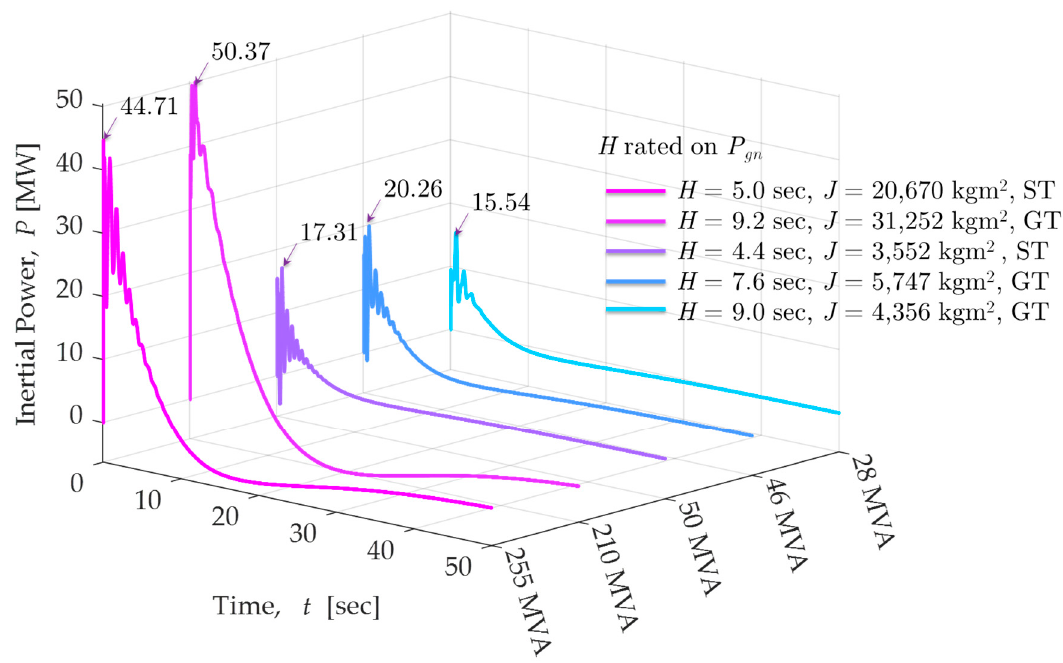
Figure 10. Inertia response of five synchronous machines to the under-frequency event shown in Figure 9.